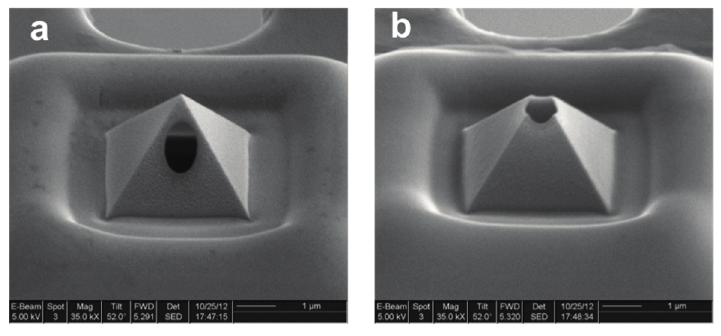
Figure 16. ( a ) Nozzle on the wall of the pyramid, keeping the tip sharpness for imaging; and ( b ) nozzle on the tip apex for direct transfer of liquid to the substrate.